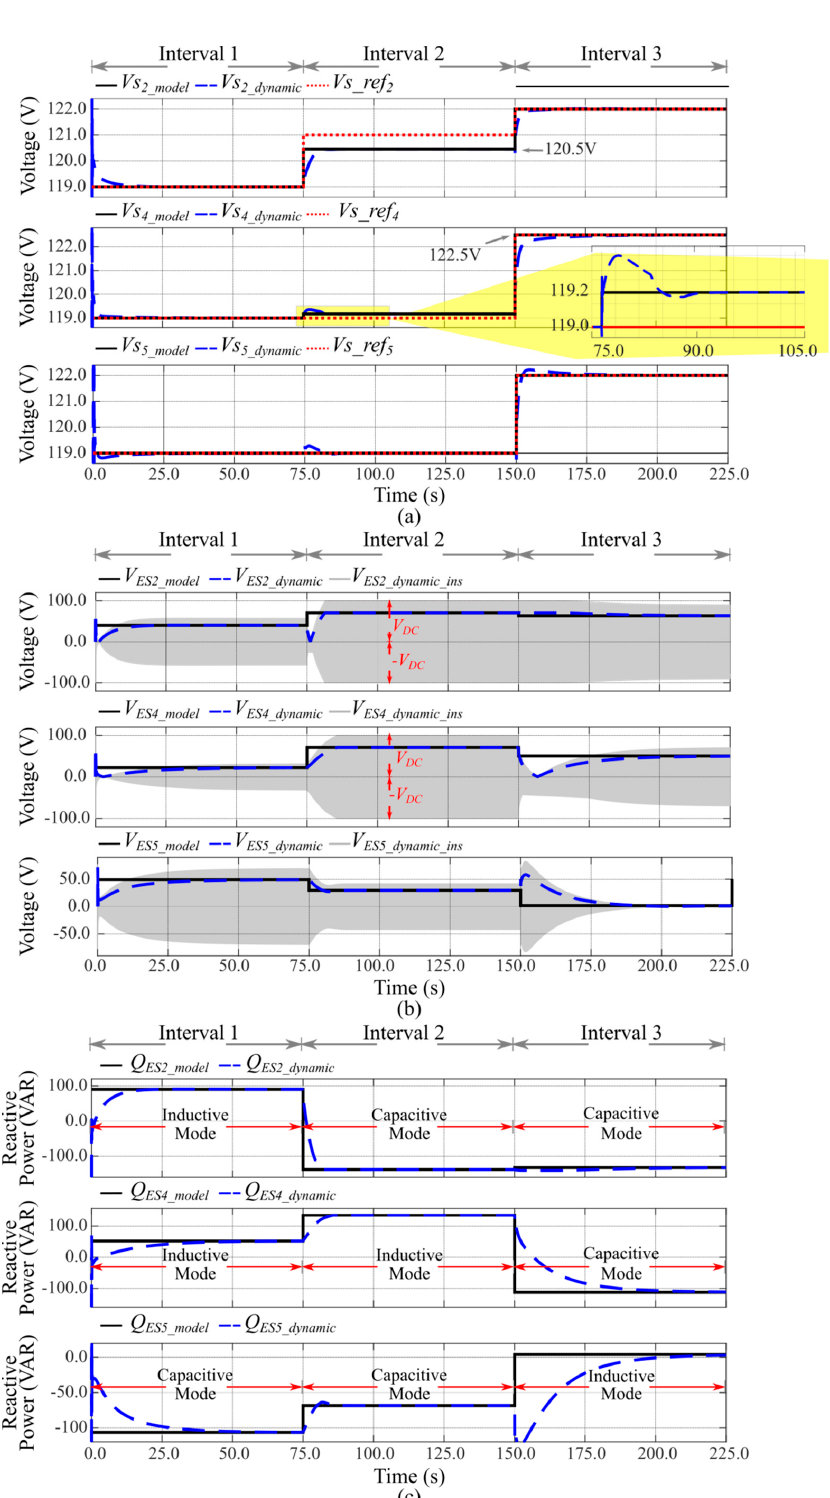
Figure 9. Electric quantities at constant power and changes in reference voltages. ( a ) Node voltages, ( b ) ESs voltages, and ( c ) ES reactive power and operation modes.